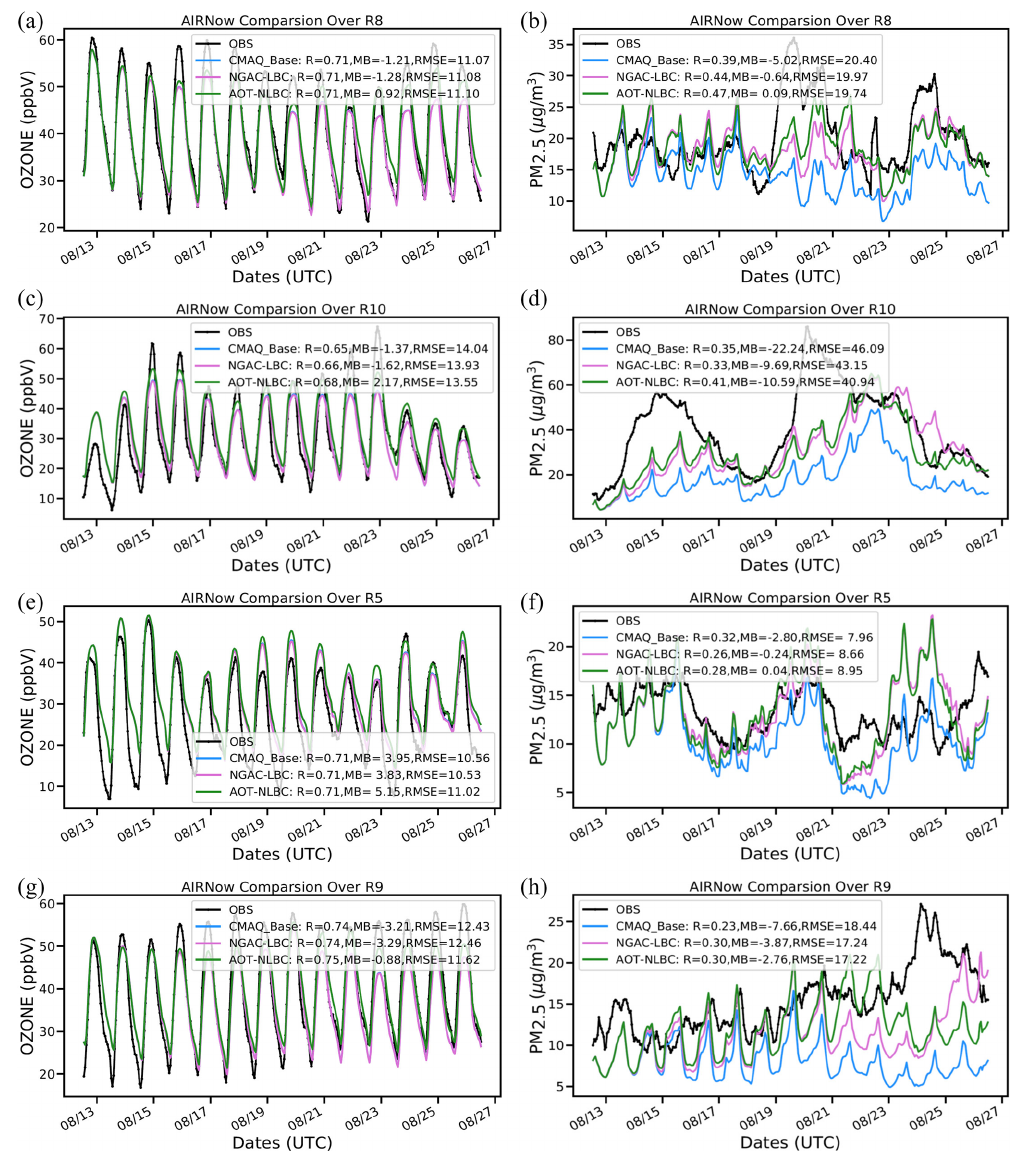
Figure 14. AIRNow time-series comparisons for surface ozone (a, c, e, g) and PM 2 . 5 (b, d, f, h) over EPA region 8 (R8, states of Montana, North Dakota, South Dakota, Wyoming, Colorado, and Utah), region 10 (R10, states of Washington, Idaho, and Oregon), region 5 (R5, states of Minnesota, Wisconsin, Illinois, Indiana, Michigan, and Ohio), and region 9 (R9, states of California, Nevada, and Arizona) predicted by CMAQ_Base, NGAC-LBC, and AOT-NLBC in August 2018. Please note that the dates in this figure are given in the format of month day